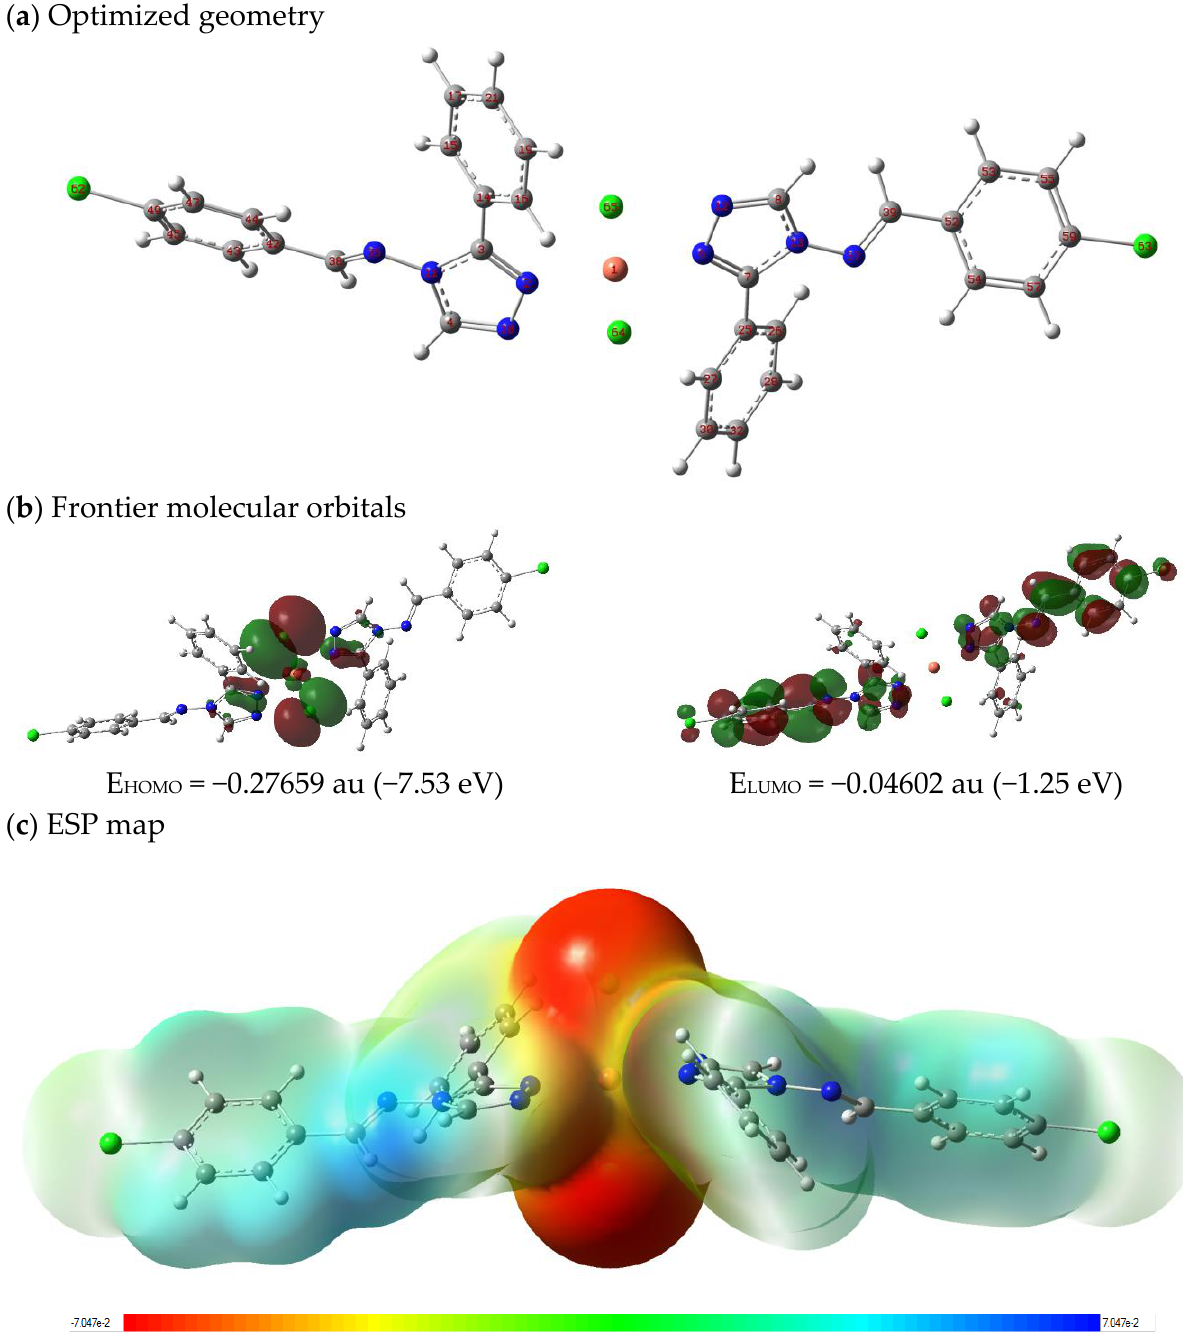
Figure 6. Optimized structure ( a ), frontier molecular orbitals ( b ) and electrostatic potential map ( c ) for the Cu (II) -complex ( 6 ) calculated at CAM-B3LYP/6-31G(d)/LanL2DZ level of theory.